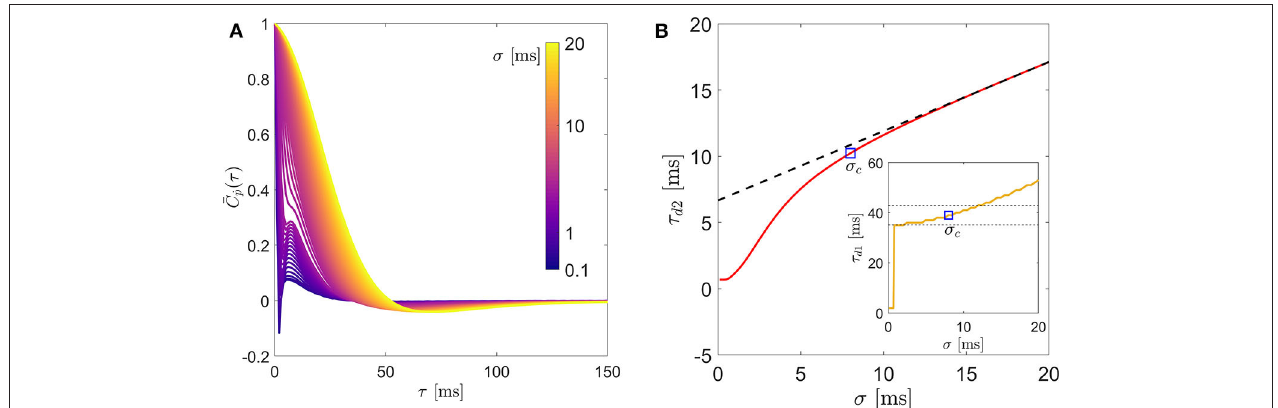
FIGURE 1 | (A) Lagrangian autocorrelation of fiber tumbling rate, (B) the integral time scale of rotation ( τ d 2 ) and in inset: the zero-crossing time ( τ d 1 ) of a representative fiber ( L = 3.2 η K , d = 0.64 η K ) for different filtering window size. The two dashed lines in the inset of (B) indicate a range of ± 10 % of τ d 1 obtained from the σ c shown by the square